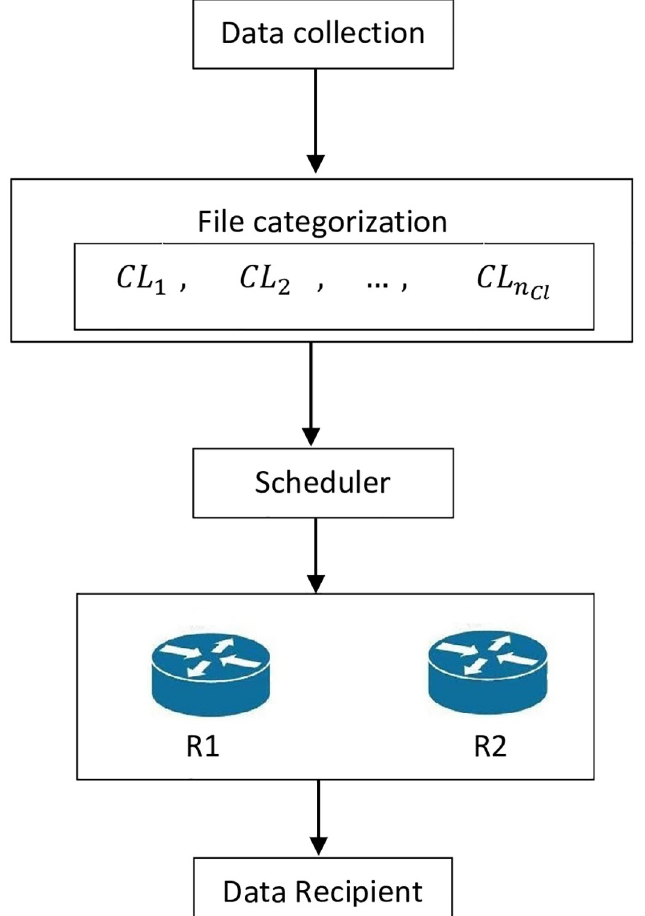
Fig 4. Novel architecture with two